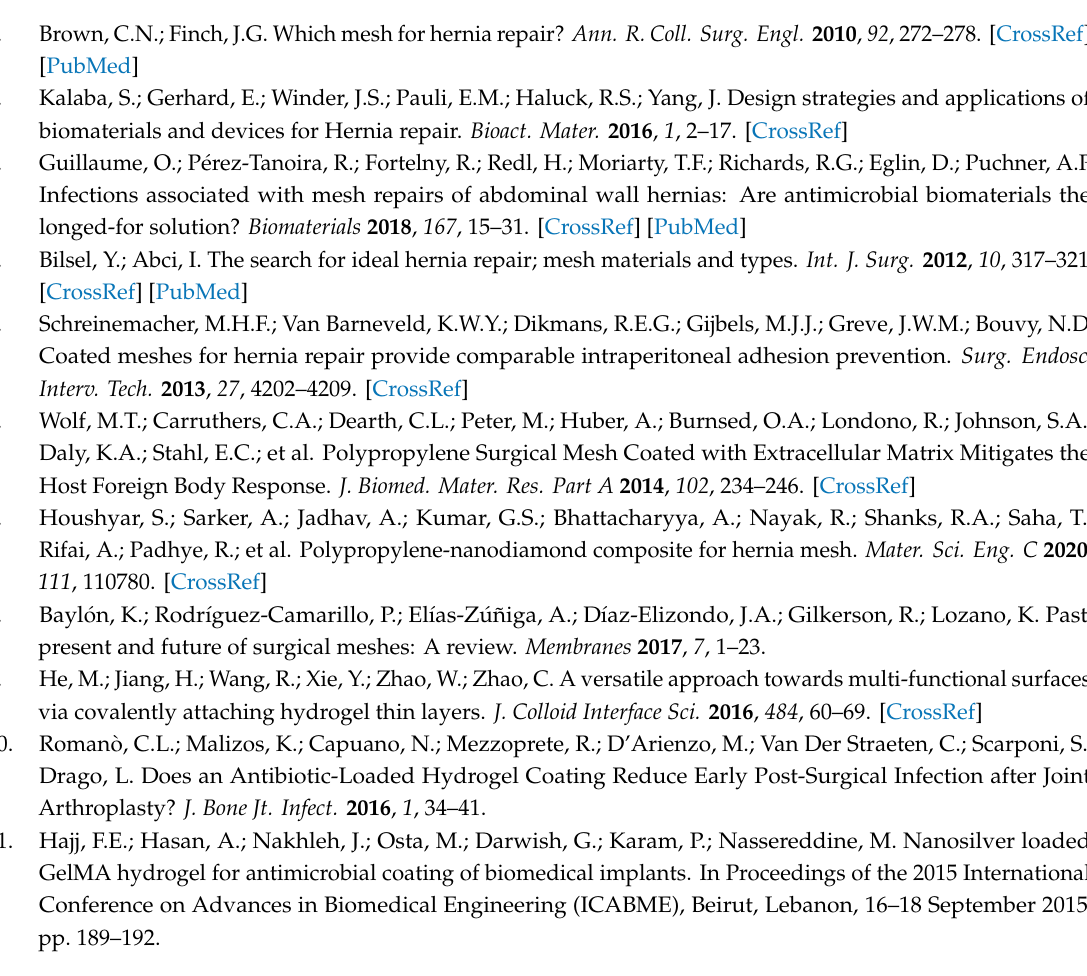
Figure S1: Micro-CT images and SEM micrographs (insets) at three days post-seeding; left column, top to bottom: PP_3 and protein-coated PP (PPG_3 and PPM_3); right column, top to bottom—PRP-treated PP (PPP_3) and PRP-treated hydrogel-coated sample PPGP_3 and